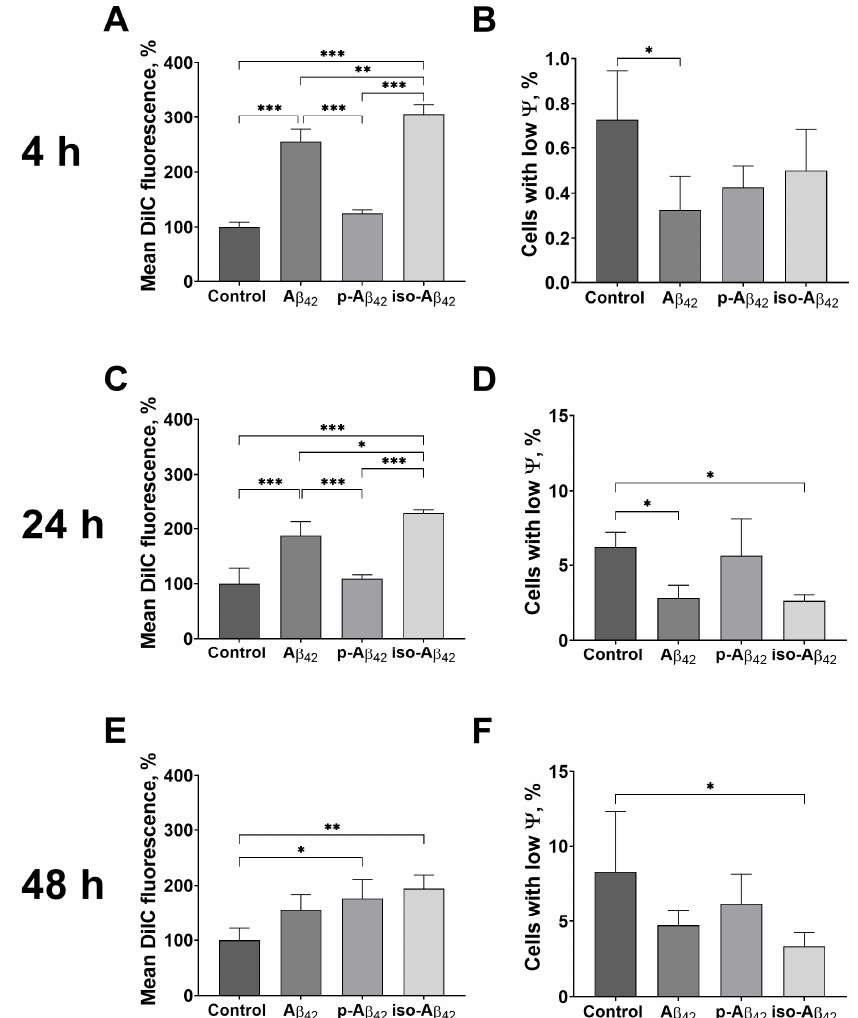
Figure 4. The effects of beta-amyloid isoforms on mitochondrial potential in bEnd.3 cells. Cells were incubated for 4 h ( A , B ), 24 h ( C , D ) and 48 h ( E , F ) with 10 µ M of A β 42 , p-A β 42 and iso-A β 42 . Flow cytometry was used to analyze changes in mean MitoProbe DilC fluorescence ( A , C , E ) and the number of cells with low mitochondrial potential ( ψ ) ( B , D , F ). Mean DilC fluorescence was nor- malized to control. The values in the control samples were taken as 100%. The mean ± SD in 3 in- dependent experiments in triplicates is shown in the figure. The statistical difference between ex- perimental groups was analyzed by one-way analysis of variance using the post hoc Tukey test for multiple comparisons. *— p < 0.05, **— p < 0.01 and ***— p < 0.001. 2.5. Iso-A β 42 Has the Most Rapid and Pronounced Effect on Mitochondrial Functioning in the Blood–Brain Barrier Cells The A β 42 isoforms affect the mitochondrial potential in different modes, and the mitochondrial potential is directly related to the mitochondrial respiration and oxidative phosphorylation processes. A schematic representation of the assessment of the respira- tion indicators (Figure 5) and representative raw data of the bioenergetic function in bEnd.3 cells (Figures 6A, 7A and 8A) are given. The parameters of bEnd.3 cellular respi-